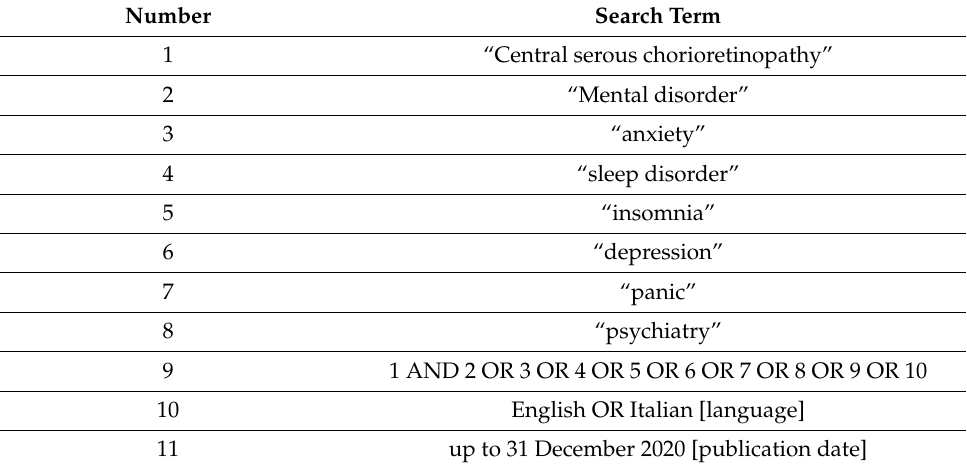
Table 1. List of search terms entered into databases search engines in order to identify the